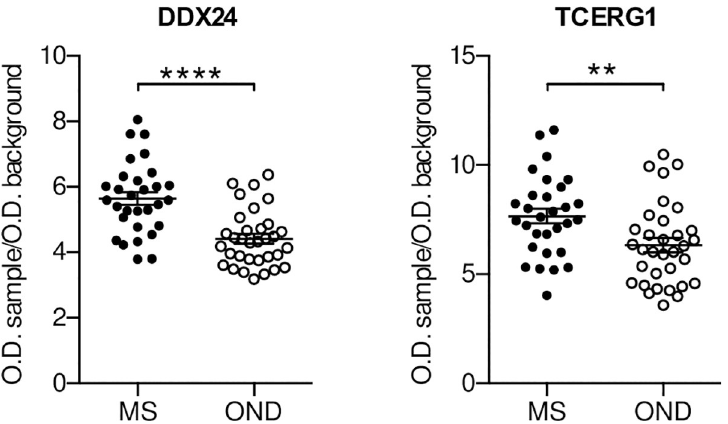
Fig 3. ELISA validation of TCERG1 and DDX24. TCERG1 and DDX24 were validate by a secondary Phage-ELISA using a bigger independent cohort (cohort 2, Table 1) of CSFs of MS (n = 30) and OND (n = 33). Individual biological replicates are shown. Error bars indicate mean +/- SEM. Unpaired t-test has been used to assess statistical significance; �� p < 0.01, ���� p < 0.0001.